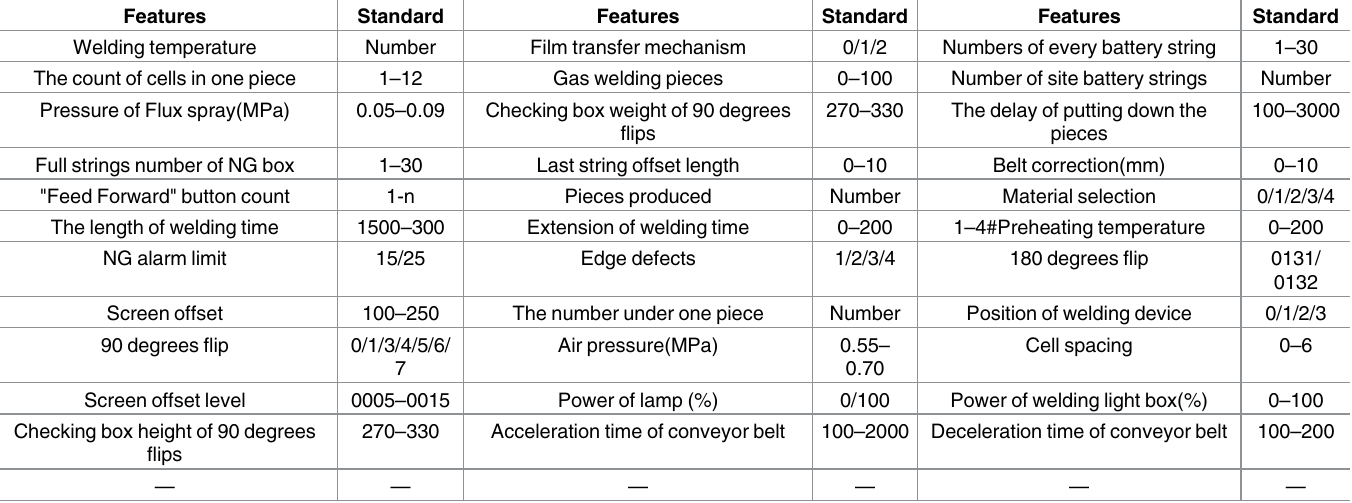
Table 2. The standard value of features.